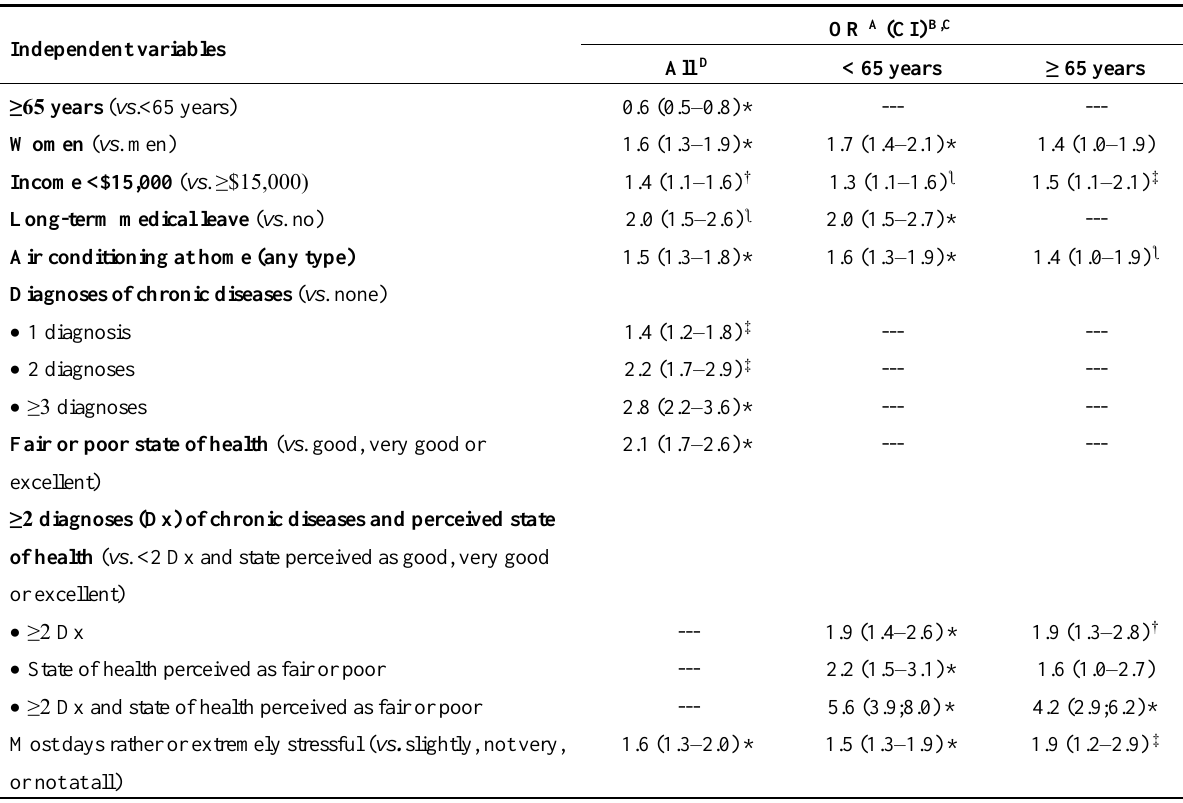
Table 8. Variables explaining the prevalence of reported adverse health impacts, very hot and humid summer